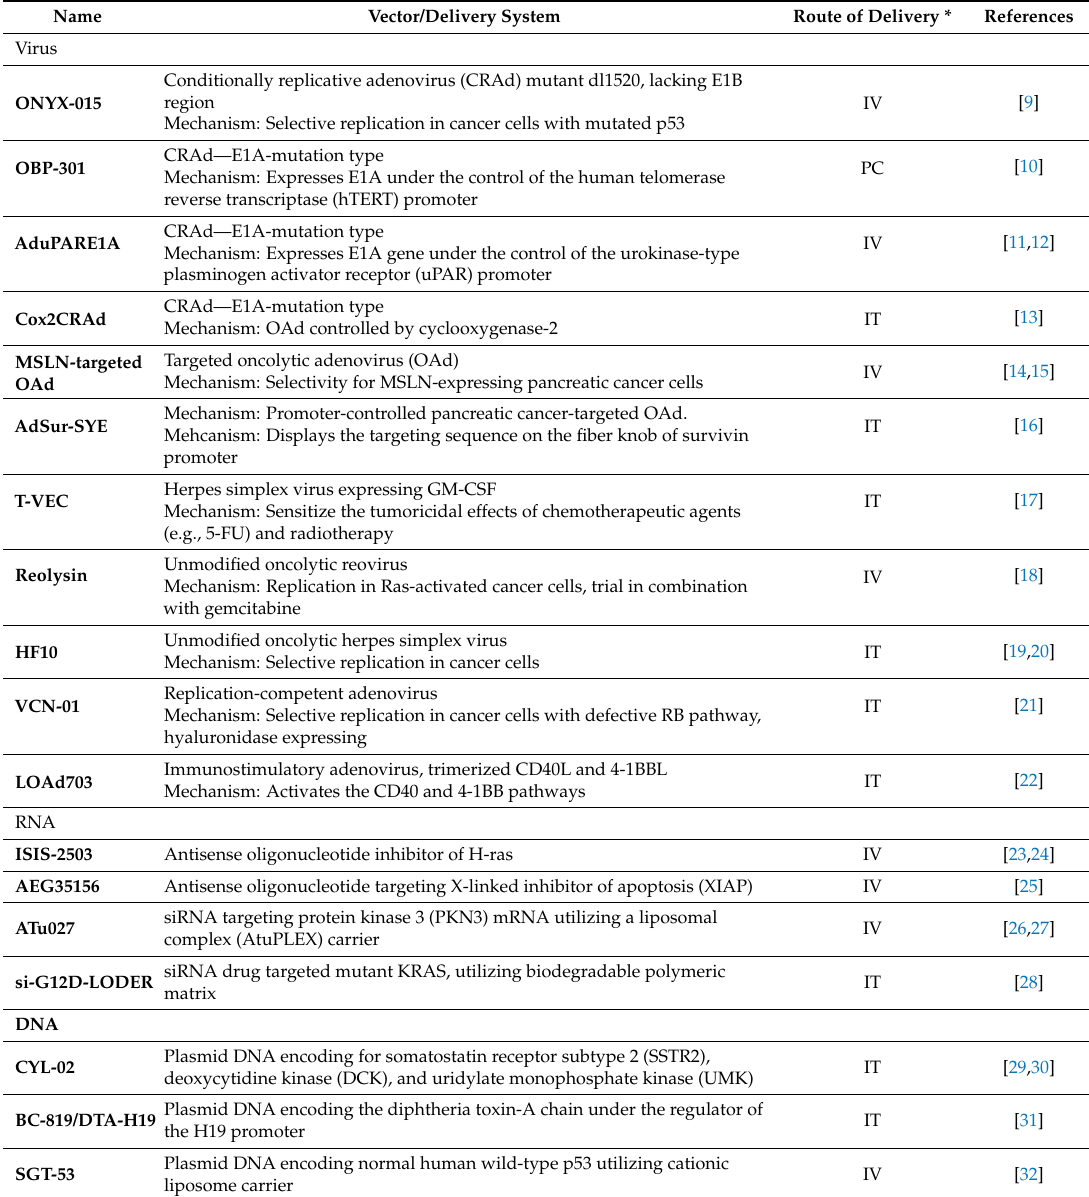
Table 1. Various therapeutic proteins coupled with viral